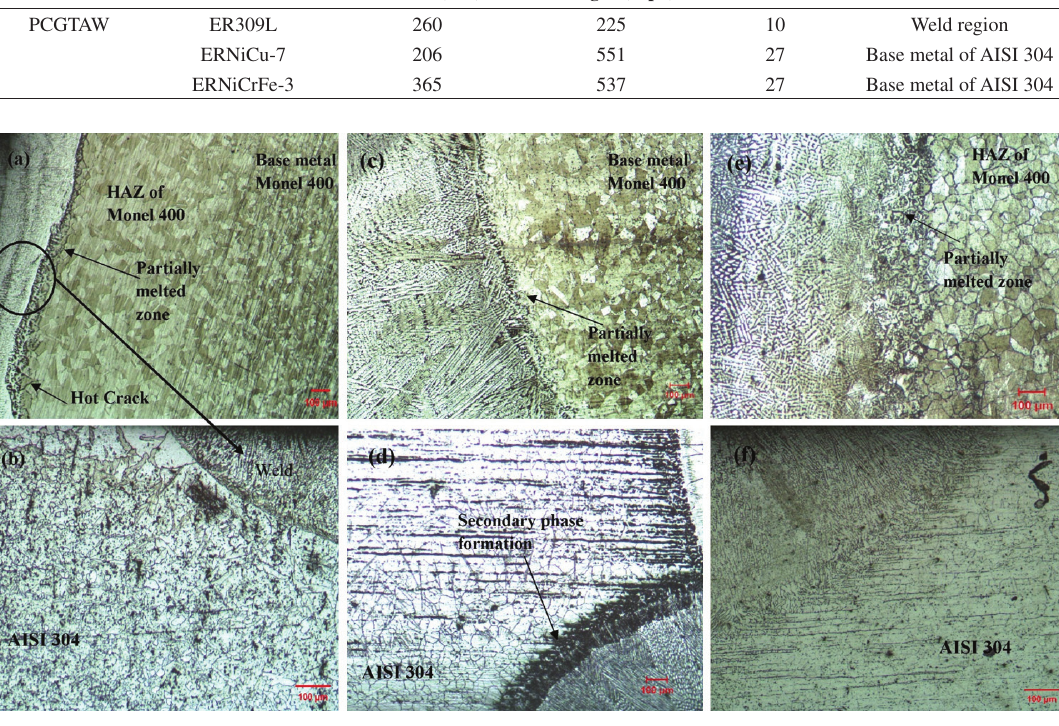
Figure 3. Microstructures showing the PCGTA welds of dissimilar Monel 400 and AOSO 304 using E309 L filler wire (a, b); ERNiCu-7 filler wire (c, d); ERNiCrFe-3 filler wire (e, f).